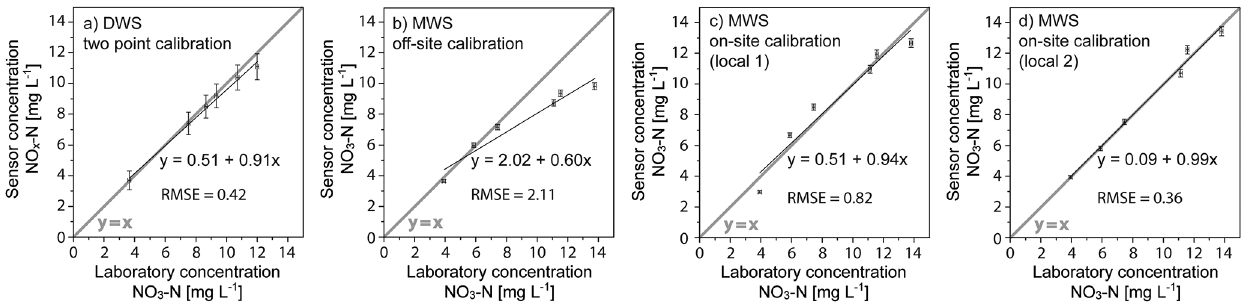
Figure 2. Accuracy of DWS and MWS immediately after calibration. Recorded sensor measurements are compared with measured concen- trations analysed in the laboratory. The RMSE was calculated by relating the measured sensor concentrations with the optimum calibration (ideal straight line y = x ).The DWS has one option for calibration, whereas the MWS offers three options for calibration. All calibration options are in addition to the factory calibration provided by the manufacturer.